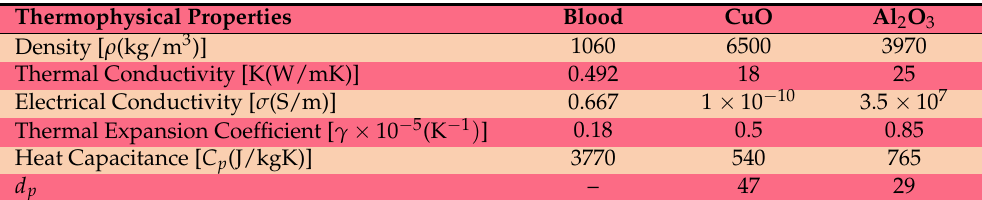
Table 1. Thermophysical properties of nanoparticles ([43]).